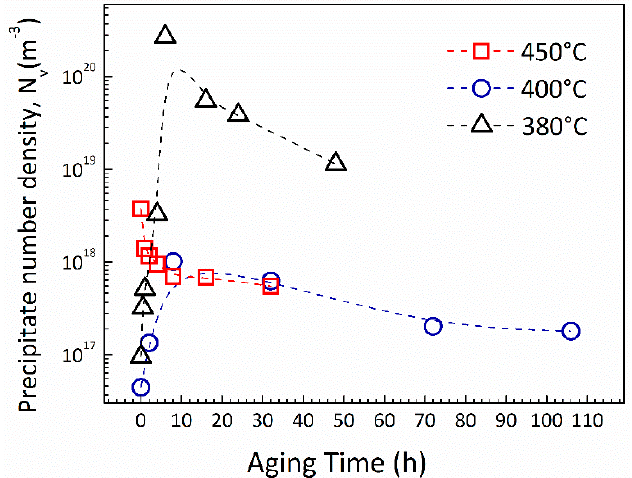
Figure 3. Precipitate number density (N v ) values measured for the different aging times and temperatures, plotted for the (PbTe) 0.95 (Ag 2 Te) 0.05 as-cast (AC) samples aged at 400 °C (blue circles) and 450 °C (red squares), as well as for the hot-pressed (HP) (PbTe) 0.97 (Ag 2 Te) 0.03 samples aged at 380 °C (black triangles). For the series of samples aged at 450 °C N v decreases with aging time, whereas for the samples aged at 400 °C and 380 °C sharp increase of N v values is indicated for short durations, followed by a decrease.